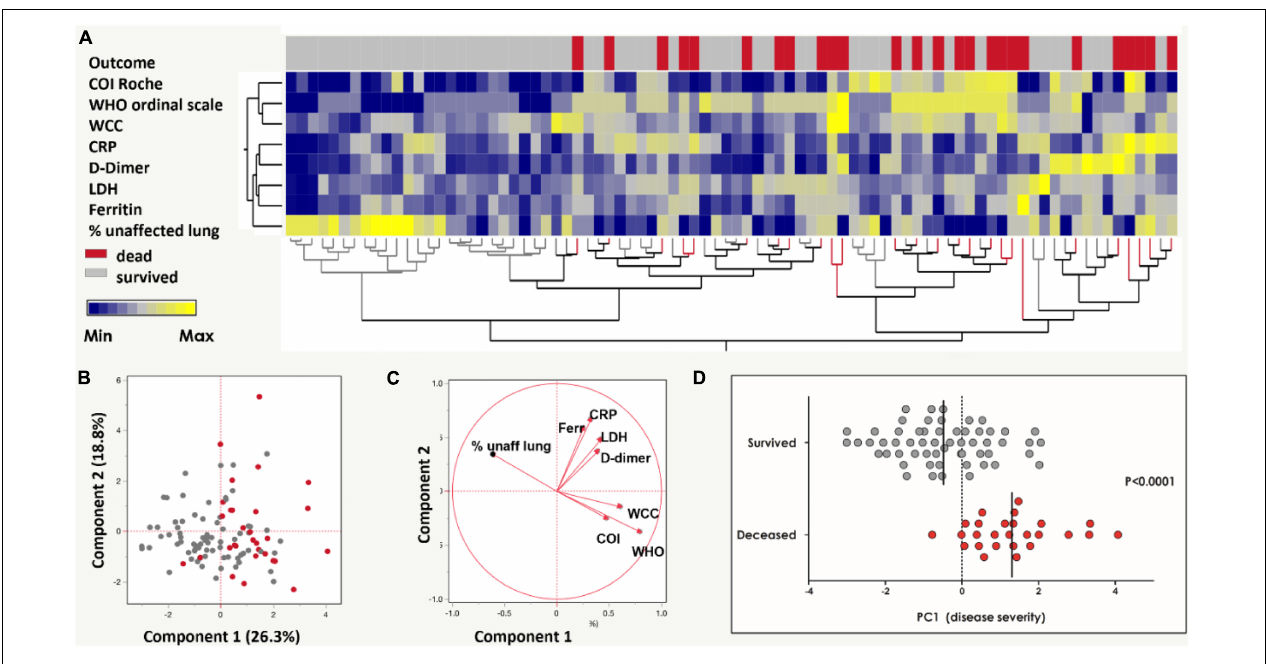
FIGURE 1 | Grading of COVID-19 disease severity among the SARS-CoV-2 infected cohort ( n = 104). (A) A two-way hierarchical cluster analysis using the WHO ordinal scale, anti-SARS-CoV-2 antibody cut-off index (COI, Roche Elecsys R (cid:13) ), white cell count (WCC), C-reactive protein (CRP), D-dimer, Ferritin, lactate dehydrogenase (LDH) and radiographic evidence of disease extent (expressed as% of unaffected lung) was used to grade COVID-19 disease by outcome (patients survived in gray and deceased in red). Data are depicted as a heatmap colored from minimum to maximum values detected for each parameter. (B) Principal component analysis (PCA) based on the eight clinical parameters (as in A ) was used to explain the variance of the data distribution in the cohort. Each dot represents a participant; 20 participants with missing data were excluded. The two axes represent principal components 1 (PC1) and 2 (PC2). Their contribution to the total data variance is shown as a percentage. (C) Loading plot showing each parameter’s influence on PC1 and PC2. (D) Comparison of PC1 scores between patients with COVID-19 who survived and died (reproduced from Riou et al., 2021). Bars represent medians and P -value is by the non-parametric Mann-Whitney test. TABLE 2 | Univariate analysis comparing virological parameters between COVID-19 patients ( n = 104) who died and survived.